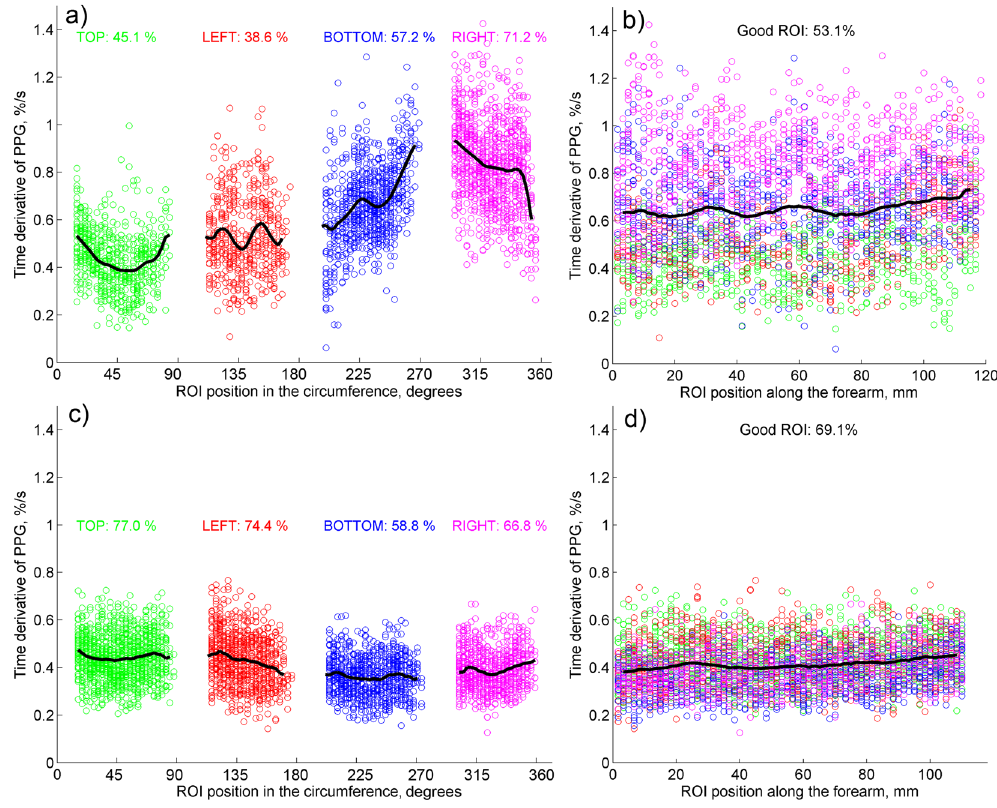
Figure 5. PPG speed calculated for two subjects in “good” ROIs. ( a ) Data scatter as a function of the ROI position along the forearm’s circumference, and ( b ) along the longitudinal direction for one of the subjects. ( c and d ) are similar data scatter for another subject. Points measured in different views of the forearm are marked by green, red, blue, and magenta for top, left, bottom, and right cameras, respectively. Colored numbers show the percentage of the good ROIs in the respective view of the